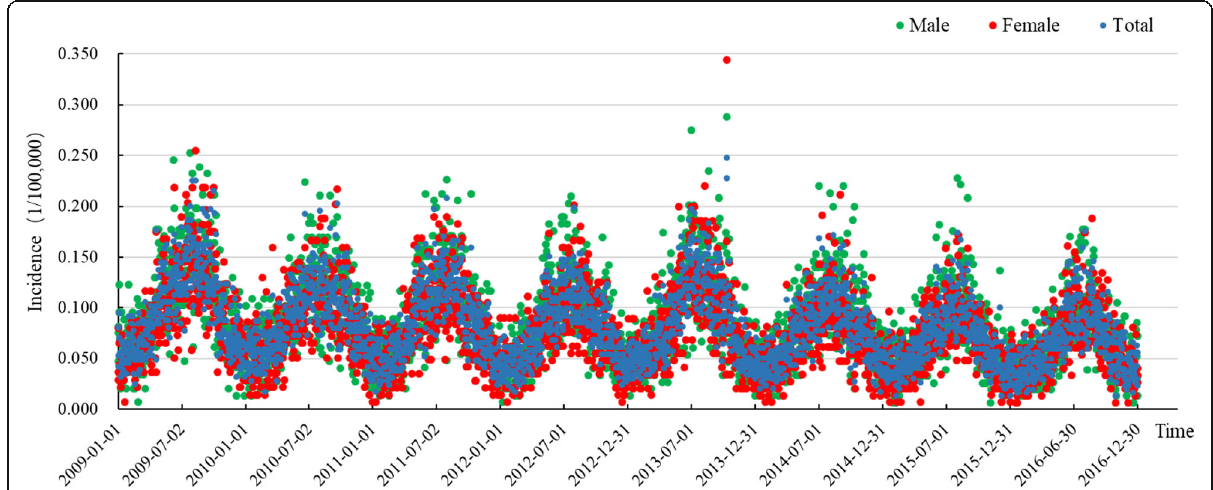
Fig. 3 Total incidence and gender distribution of bacillary dysentery in Chongqing from 2009 to 2016 (daily)